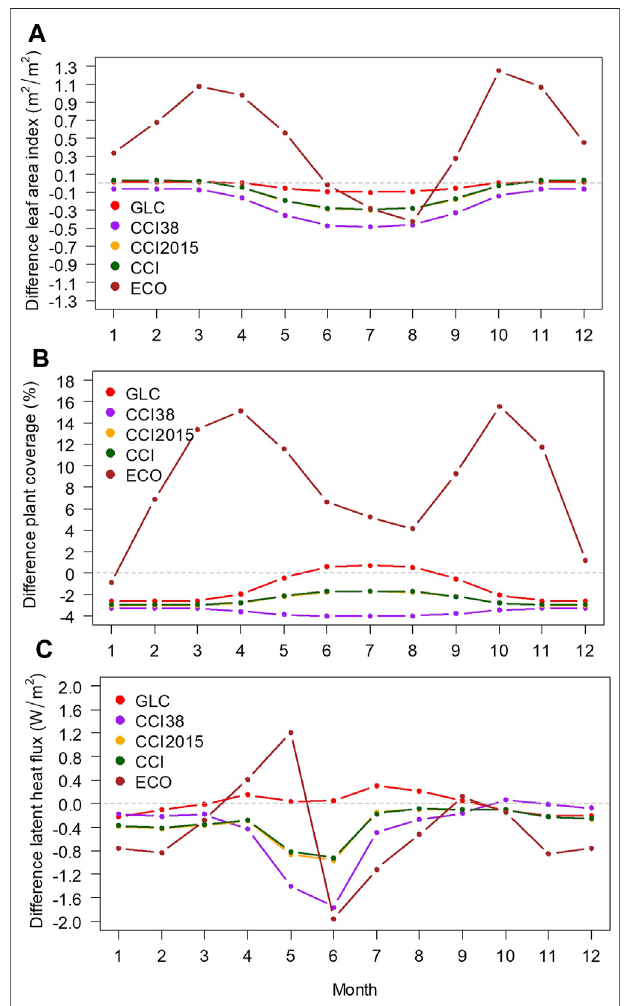
FIGURE 5 | Annual cycle climatology (2002 – 2011) of the differences in leaf area index (A) , plant coverage (B) and latent heat (C) in the simulation experiments with land cover map GLC (red), CCI38 (purple), CCI 2015 (yellow), CCI (green), and ECO (brown) compared with the control simulation based on GC. Please see Table 1 for